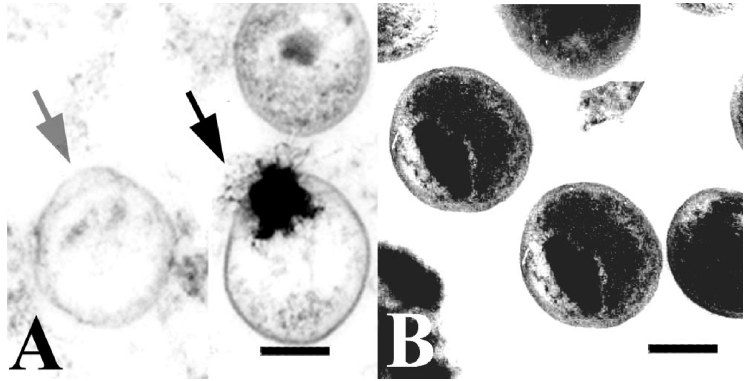
Figure 5. Scanning electron microscopy images of C. trachomatis exposed to cecropin peptide D2A21 for 90 min. ( A ) Organisms treated with D2A21 appear to be hollow or in the process of leaking their cytoplasmic contents (black arrow); ( B ) Untreated organisms incubated in SPG only. Bar = 0.5 µ m. Adapted with permission from [69]. Copyright 2002 American Society for Microbiology.